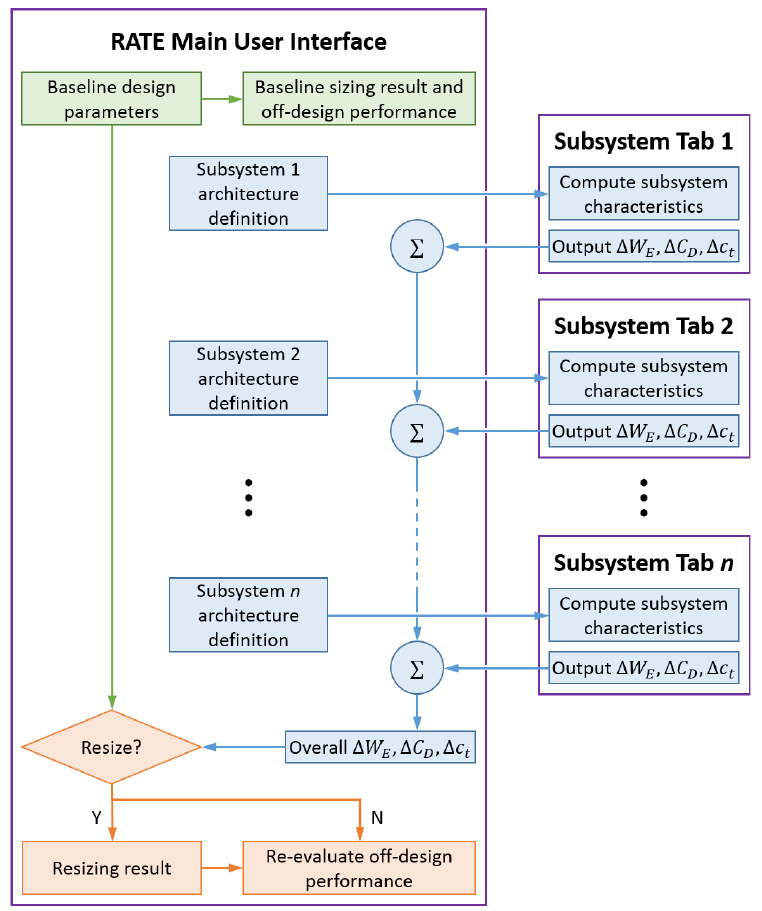
Figure 2. Data flow between RATE main user interface and subsystem